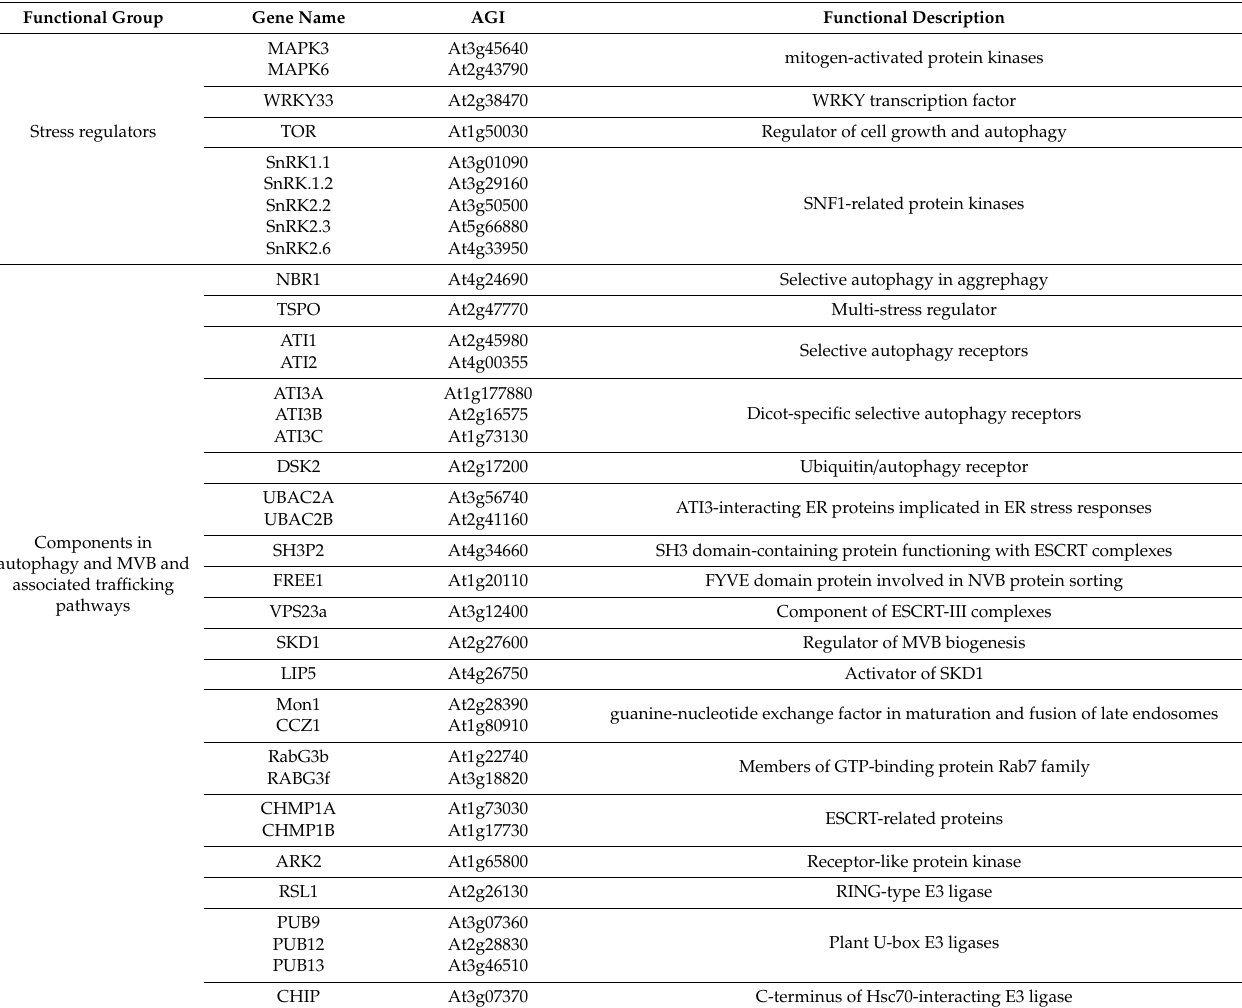
Table 1. Important Arabidopsis genes in autophagy and MVB (multivesicular body) coordination in plant stress responses. Functional